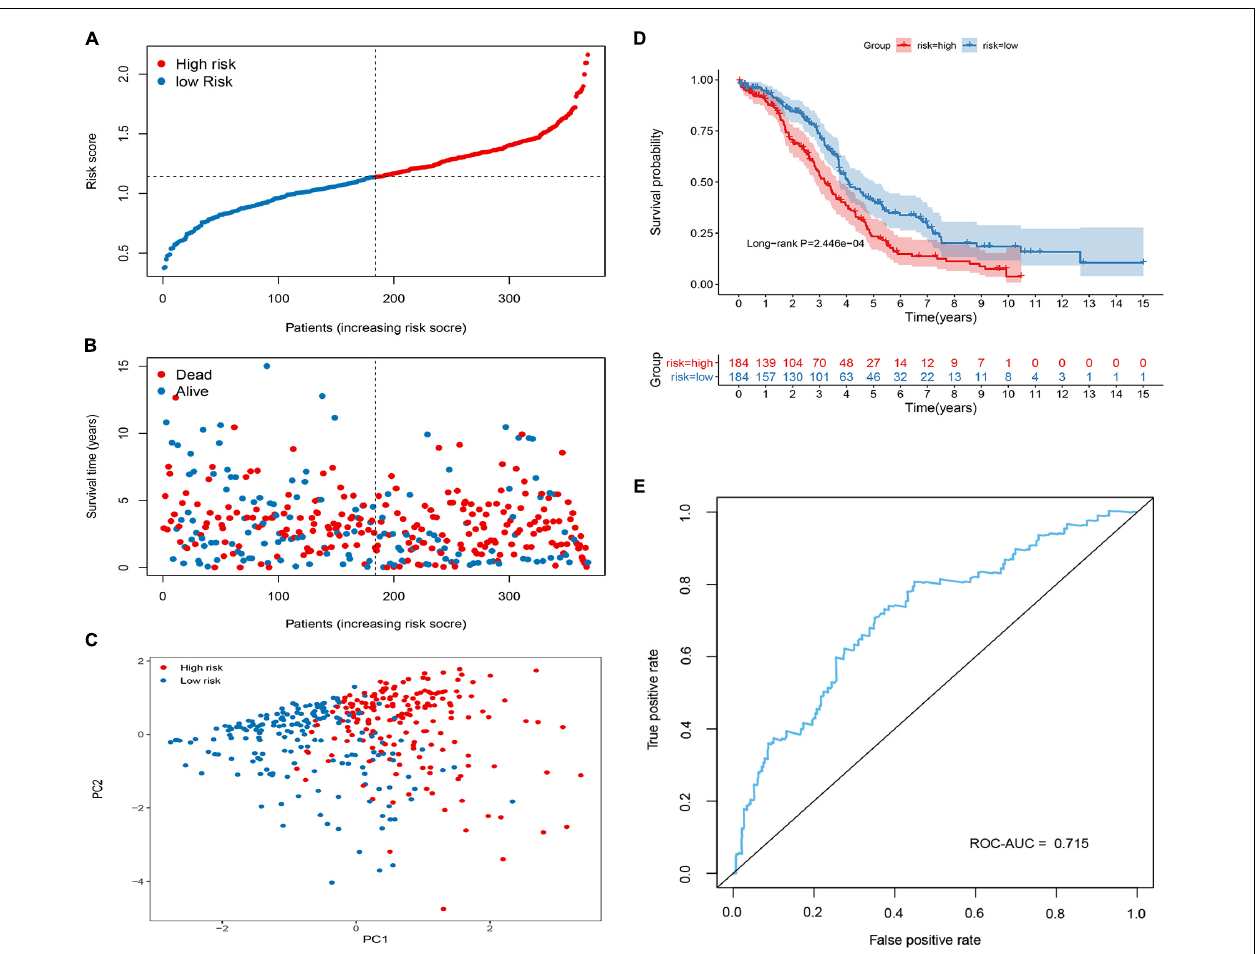
FIGURE 3 | Construction of the methylated related gene signature in the Cancer Genome Atlas (TCGA) cohort. (A) Dot plot of risk score. Y axis represents risk score. Red and blue color dots represent, respectively, high and low risk score samples. (B) Dot plot of survival. Y axis represents survival times (years). Red and blue color dots represent, respectively, dead and living OC samples. (C) PCA plot of the TCGA cohort. (D) Kaplan–Meier (KM) estimate of the overall survival (OS) in the TCGA cohort. (E) The time-dependent ROC curves in the TCGA cohort.